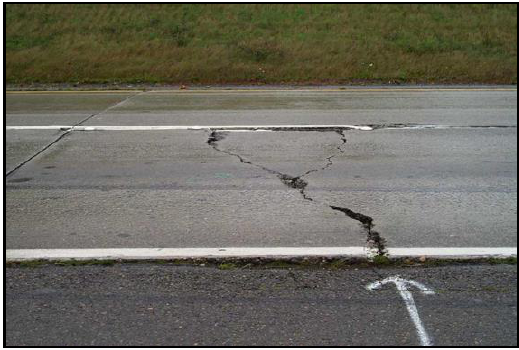
Figure 2. Crack formation on the road (Movea,